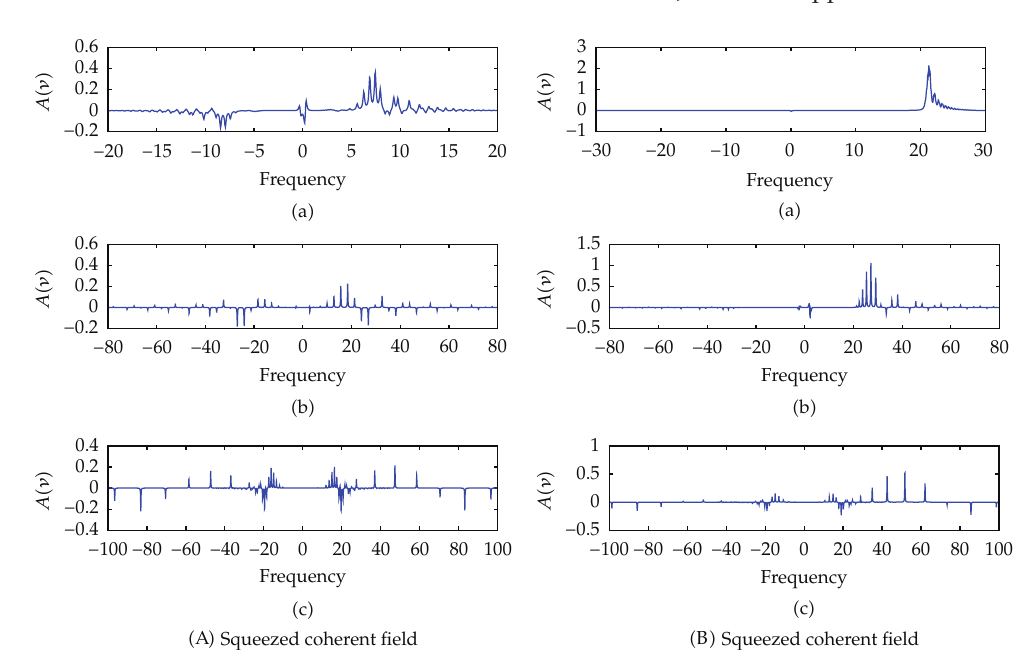
Figure 3: The same as Figure 2 (cid:5) B (cid:8) but with (cid:5) 1 (cid:8) Δ 1 (cid:9) 5 , Δ 2 (cid:9) 4, (cid:5) 2 (cid:8) Δ 1 (cid:9) Δ 2 (cid:9)